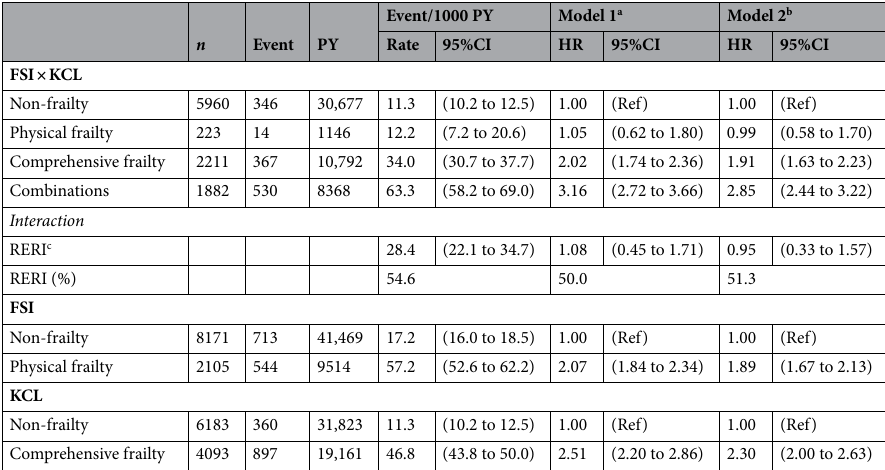
Table 2. Hazard ratios for frailty status and all-cause mortality calculated using multivariate Cox proportional hazards analysis. CI confidence interval, FSI frailty screening index, HR hazard ratio, KCL kihon checklist, RERI relative excess risk due to interaction, PY person-years. a Model 1: Adjusted for age, sex, and population density. b Model 2: In addition to the factors listed in Model 1, adjusted for family structure, economic status, educational attainment, smoking status, alcohol consumption status, sleep time, medication use, and number of chronic diseases. c We estimated that p < 0.05 when the 95% CI of the RERI exceeded 0, and p ≥ 0.05 when the 95% CI of the RERI did not exceed 0.